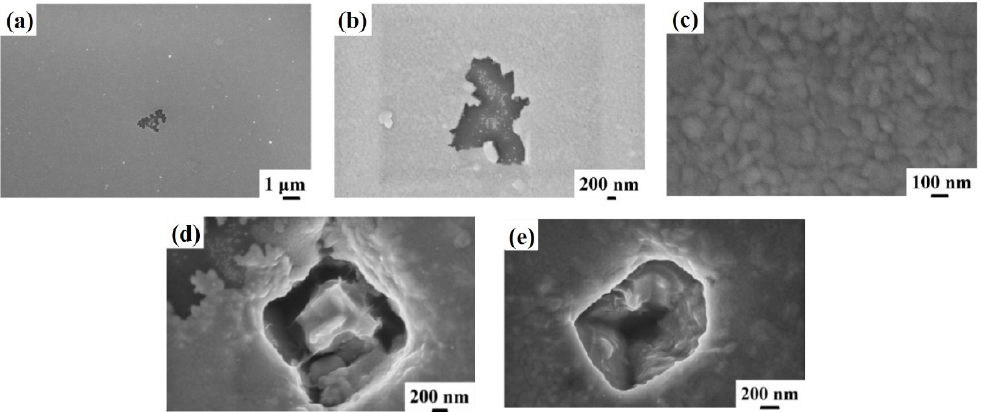
Figure 4. Representative plan-view SEM images of the Al surface for the sample: ( a , b ) 2H (Si/TiN/Al + 500 °C 15 min) with increasing magnification from ( a ) to ( c ). Regarding the same sample, ( d ) and ( e ) highlight the peculiarity of some surface defects appearing as holes in the Al layer.